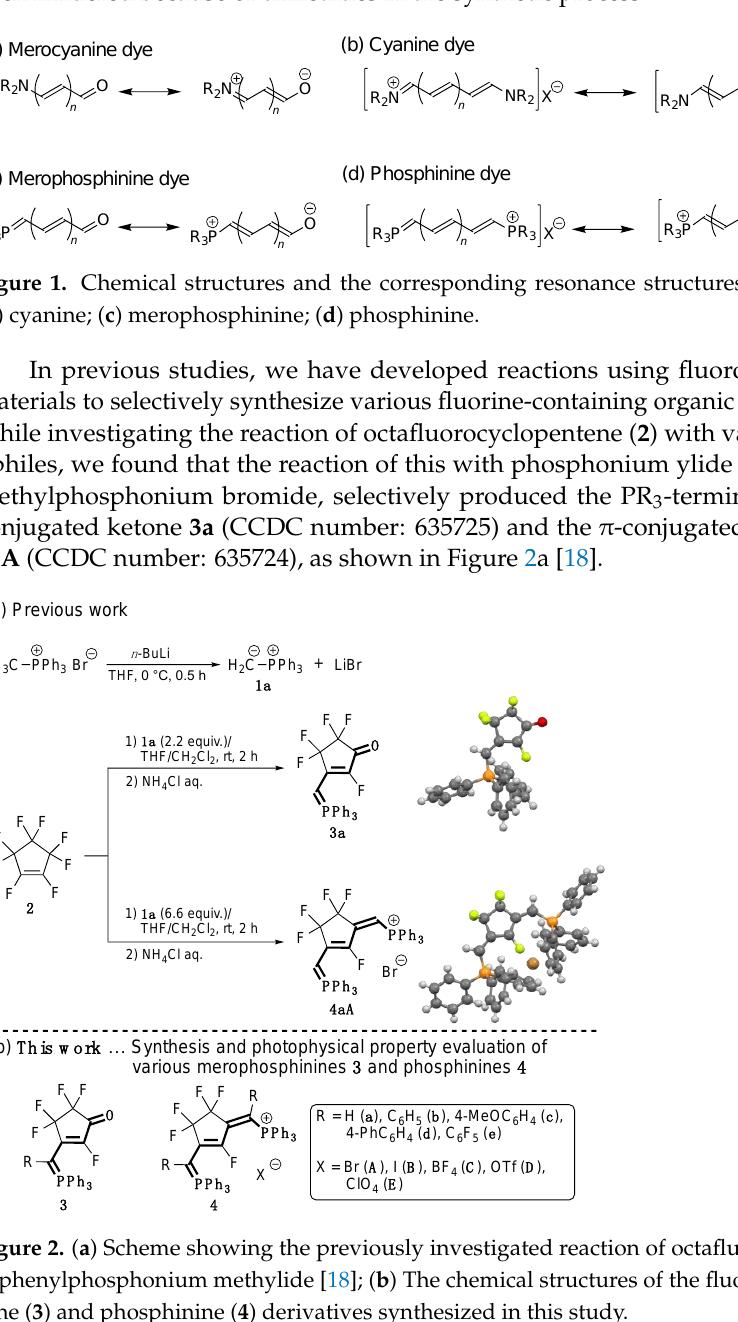
Figure 2. ( a ) Scheme showing the previously investigated reaction of octafluorocyclopentene with triphenylphosphonium methylide [18]; ( b ) The chemical structures of the fluorinated merophos- phinine ( 3 ) and phosphinine ( 4 ) derivatives synthesized in this study.